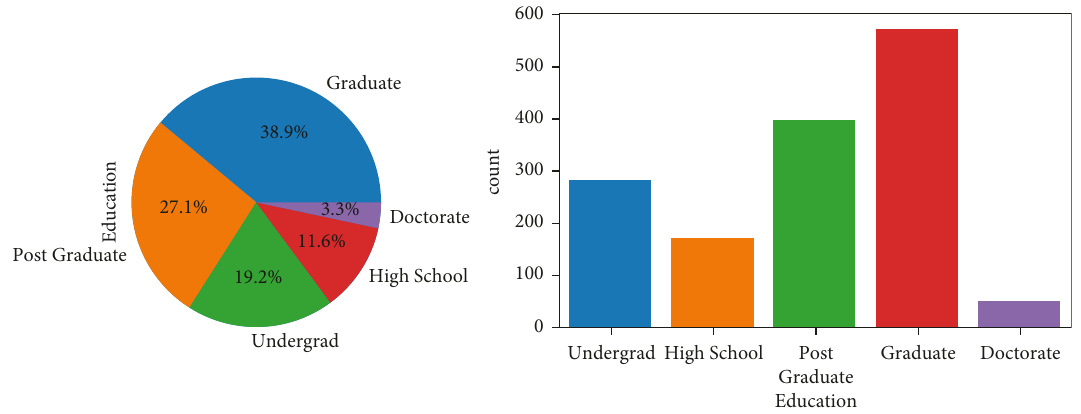
Figure 6: Attrition on the basis of education